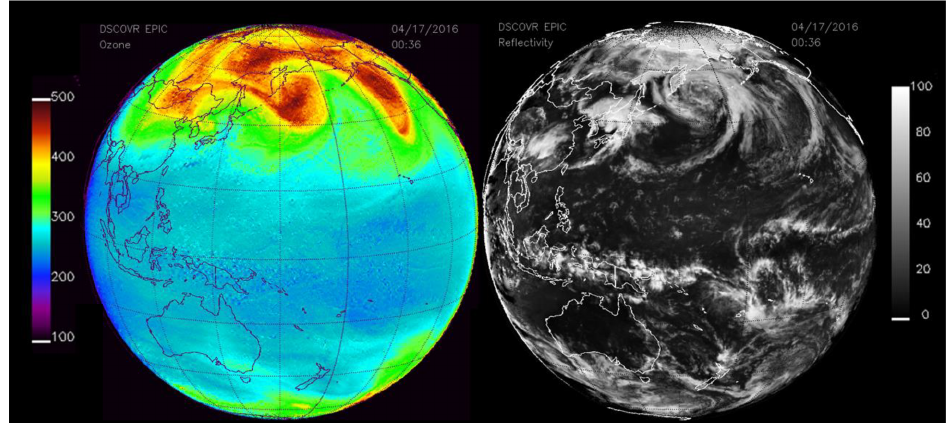
Figure 4. EPIC-retrieved ozone and LER values for 17 April 2016 at 00:36 UTC. The ozone scale is from 100 to 500DU, and the LER scale is from 0 to 100%.